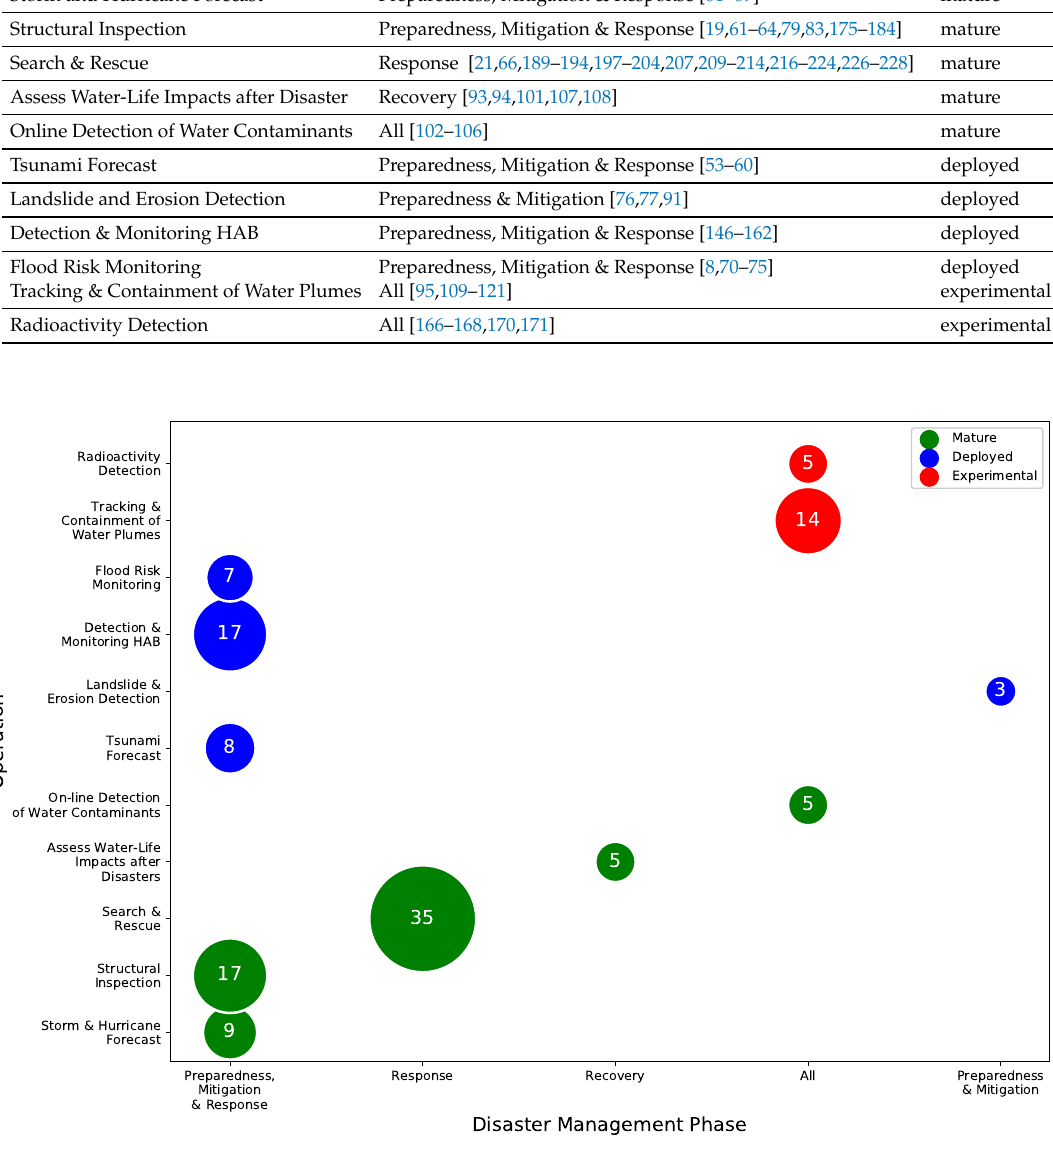
Figure 3. Visual representation for the number of works in Table